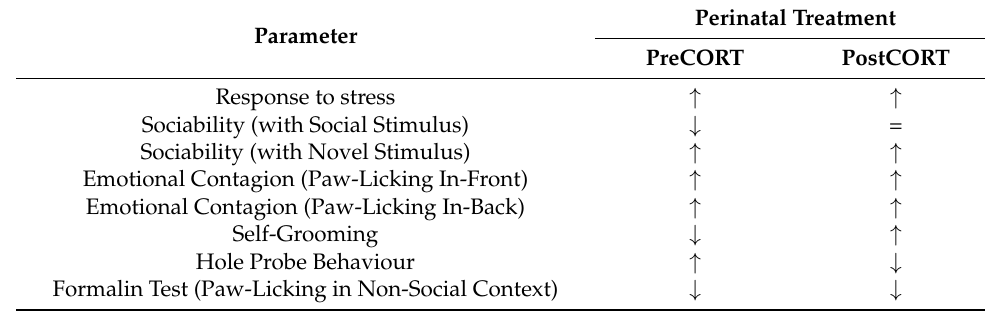
Table 3. Summary of the effects due to perinatal treatment on physiology and behaviour. Comparison between saline-treated PreCORT and PostCORT subjects ( n = 8 for each group) and saline-treated AFR subjects ( n =